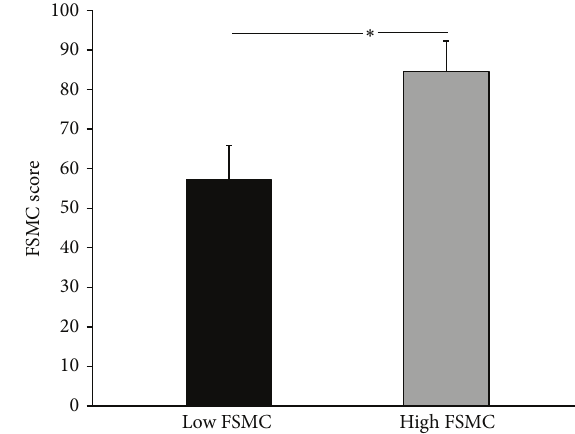
Figure 1: Fatigue severity classification derived from 𝐾 -mean cluster analysis. Low FSMC represents mild to moderate PSF group ( 𝑛 = 16 , mean = 57 ± 9 ); high FSMC represents severe PSF group ( 𝑛 = 14 , mean = 84 ± 7 ); ∗ 𝑝 < 0.001